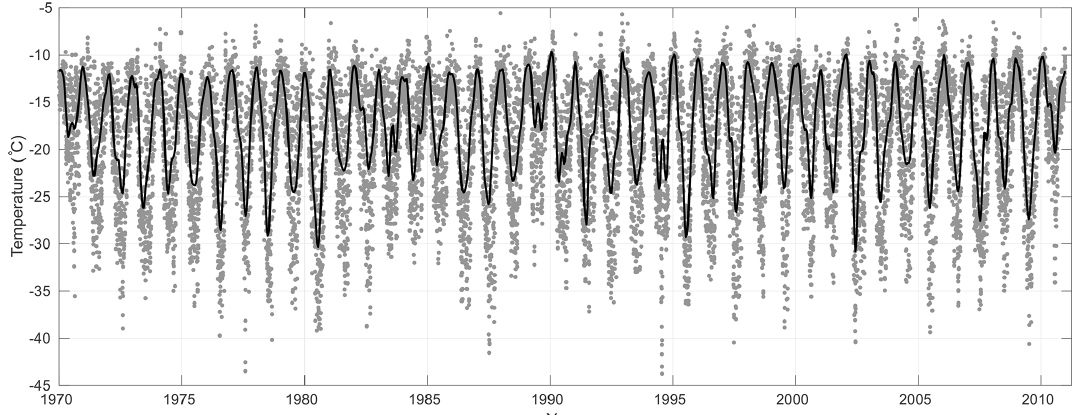
Figure 3. The grey dots are the interpolated and decimated temperature time series T (t) . The solid curve is its smoothed and gained counterpart T (t)